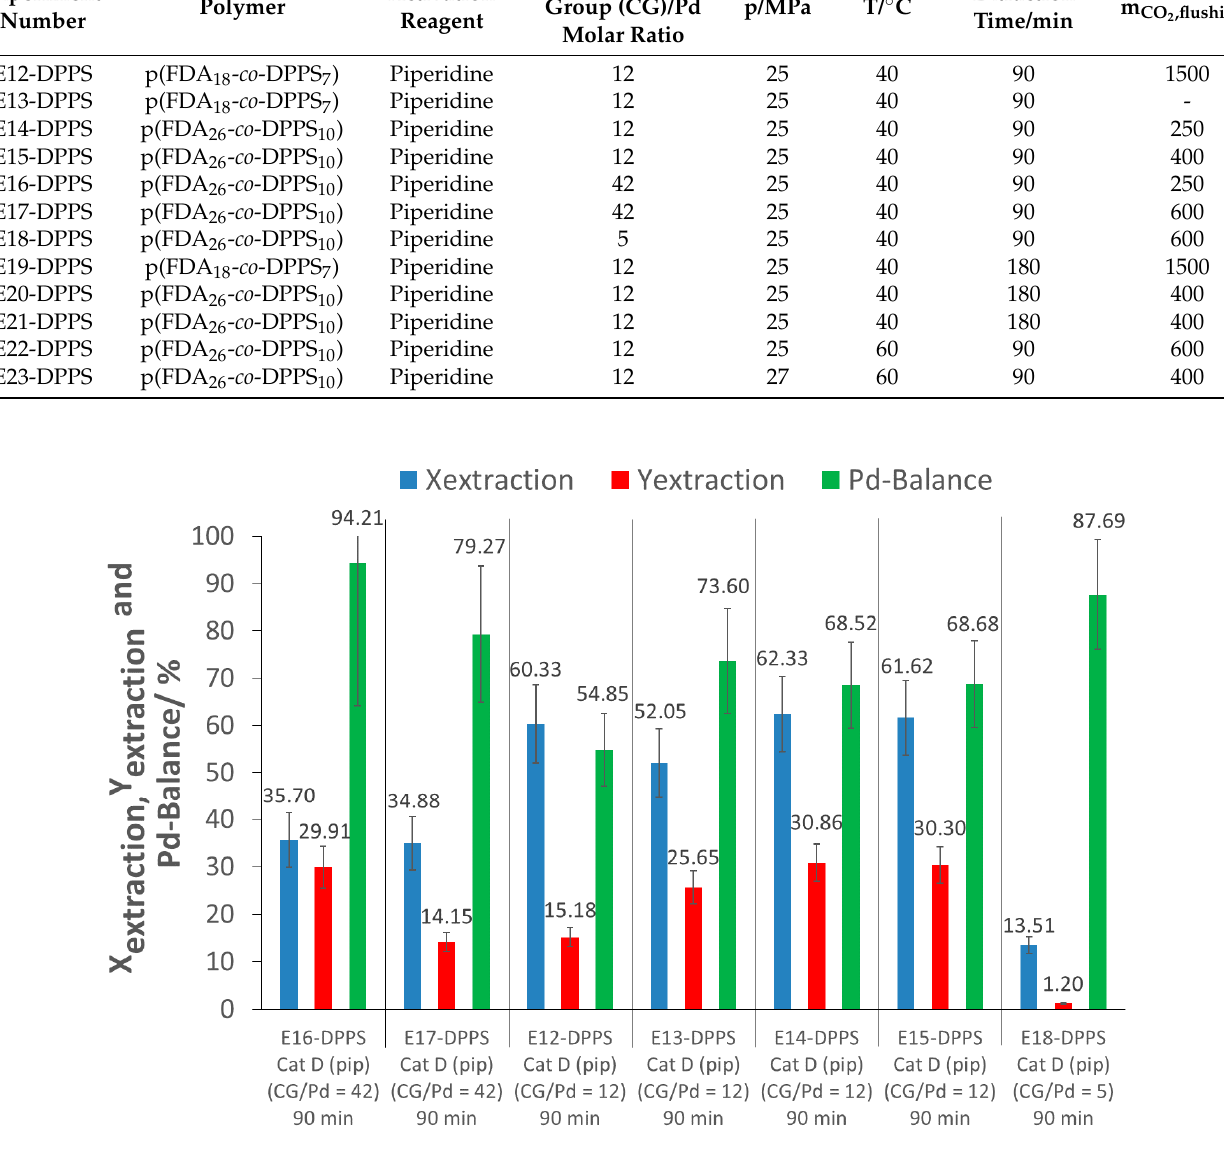
Figure 7. Results of the extractions of Pd with p(FDA- co -DPPS) at decreasing CG/Pd ratios ((pip): piperidine; CG/Pd: Complexing group/Pd ratio; Ex-DPPS: Detailed investigation experiments).